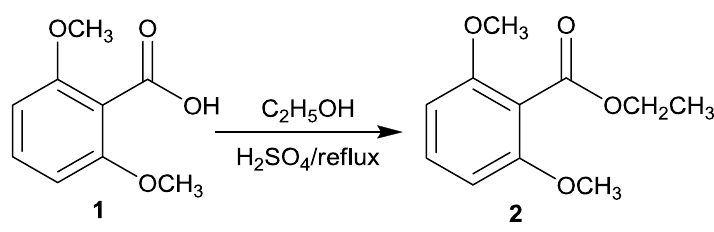
Figure 1. The synthesis of title compound 2